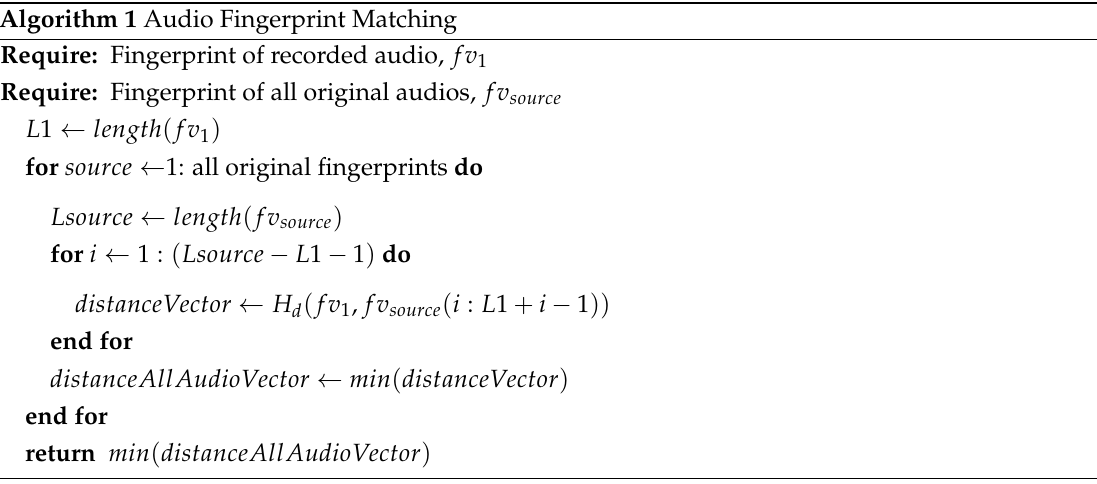
Algorithm 1 Audio Fingerprint